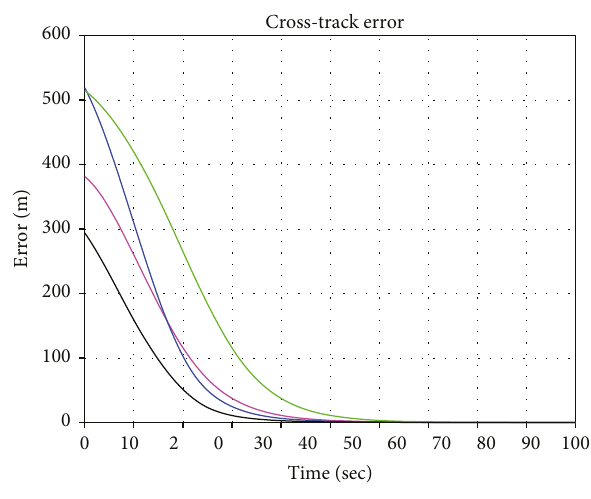
Figure 13: Cross-track